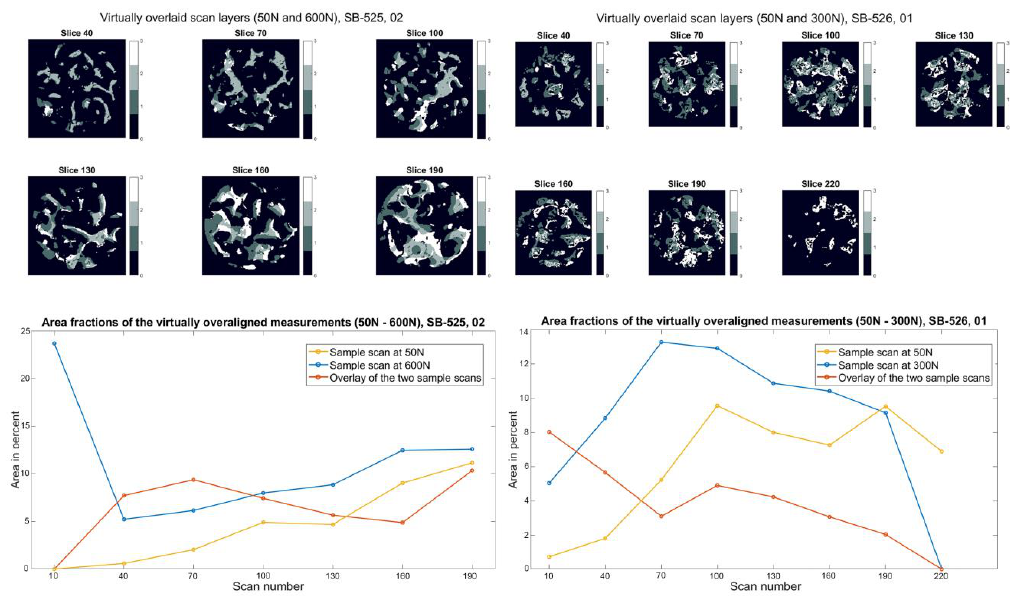
Figure 7. Slice view of the virtually superimposed 3D images (SB 525: 50 N and 600 N, SB 526: 50 N and 300 N). The different components are declared in each layer with numbers from 0–3 and the corresponding color. 0 Background, 1 Sample image (50 N/600 N and 50 N/300 N), 2 Superimposed area of the two 3D images, 3 Initial images (50 N). The course of the area fractions of the sample image (50 N/600 N and 50 N/300 N), the source image (50 N), and the superimposed area over the different layers are summarized in a diagram.